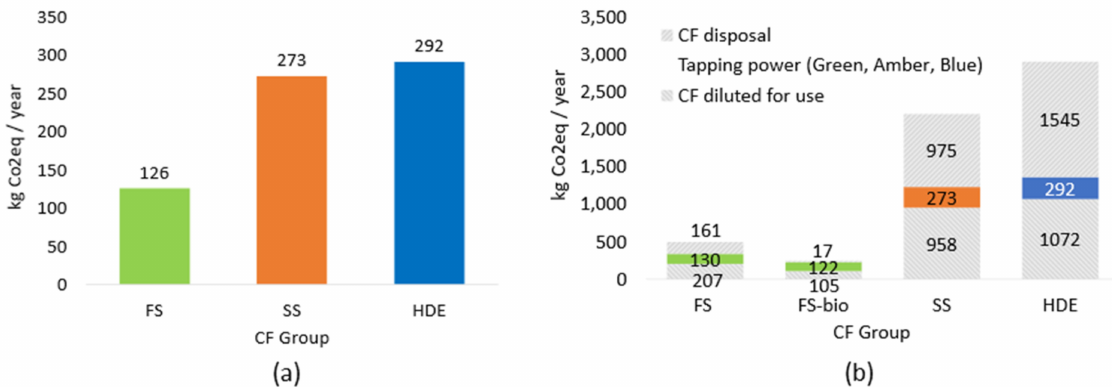
Figure 10. Annual GHG emission from machine tapping power ( a ) and comparison of annual carbon equivalent emission for the CF diluted for use, machine tapping power and end of life disposal ( b